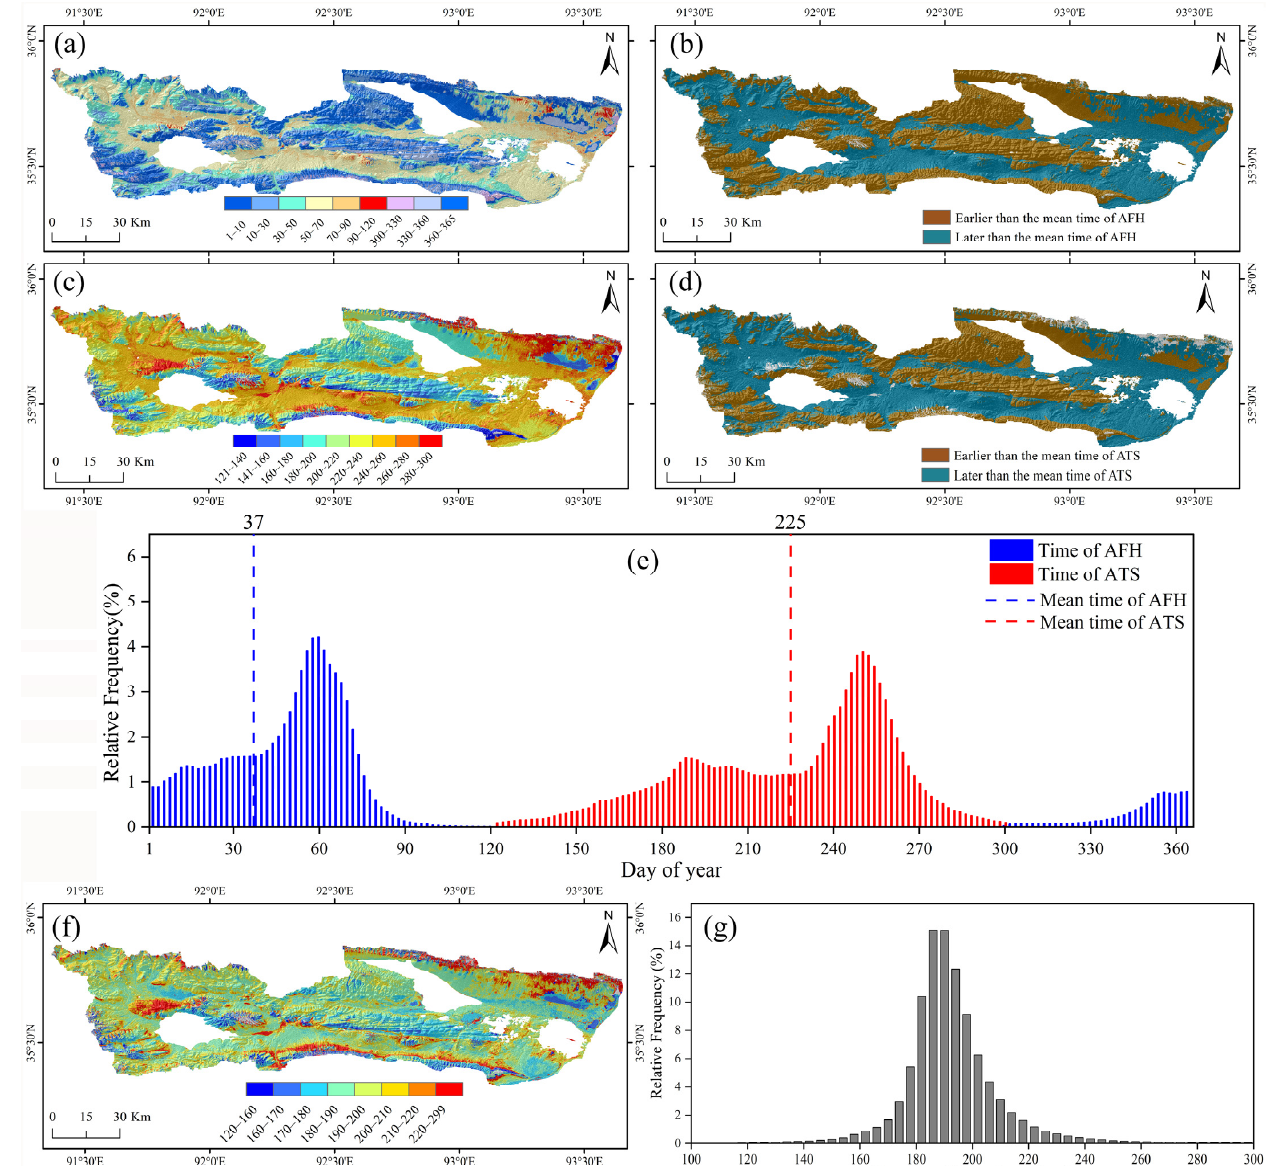
Figure 7. Characteristics of seasonal deformation time. ( a , b ) The date of MFH and classification based on the average date of MFH, respectively; ( c , d ) the date of MTS and the classification type based on the average date of MTS, respectively; ( e ) the statistics of the date of MFH, and the date of MTS; ( f , g ) the thawing duration spatially and its value statistics, respectively.